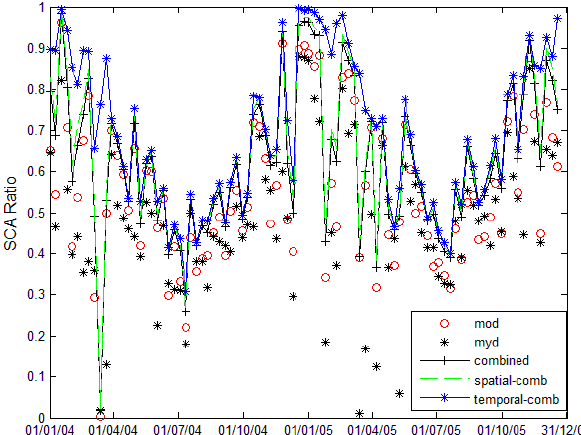
Figure 4. Filtered MODIS 8-day snow-cover products (2004– 2005). The term mod is the snow cover area from MOD10A2 prod- ucts, myd is MYD10A2 products, combined is the combined re- sult from step1, spatial-comb from step2 and temporal-comb from step3. See Sect. 2.2.3 for